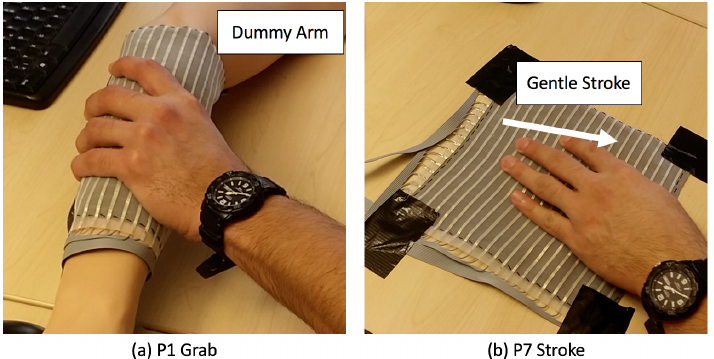
Figure 4. Experiment setup and gesture example ( a ) P1 Grab and ( b ) P7